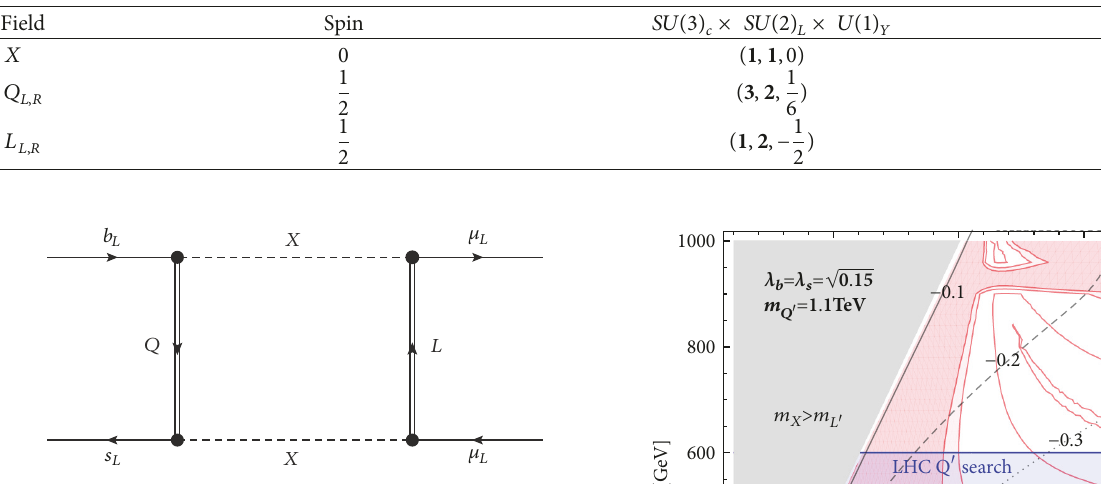
Table 3: New scalars and fermions in the model of [13]. The 𝑈(1) 푋 symmetry is global.